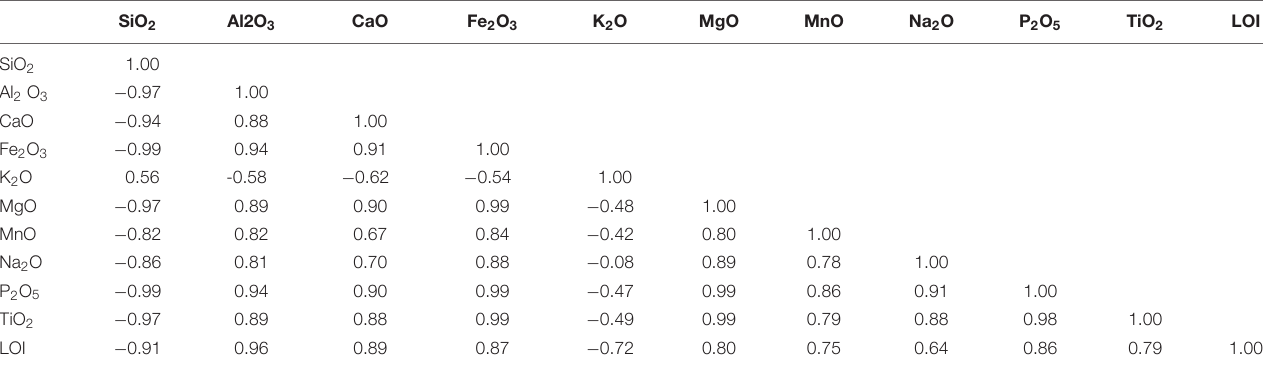
TABLE 5 | Correlation coefficients of major elemental